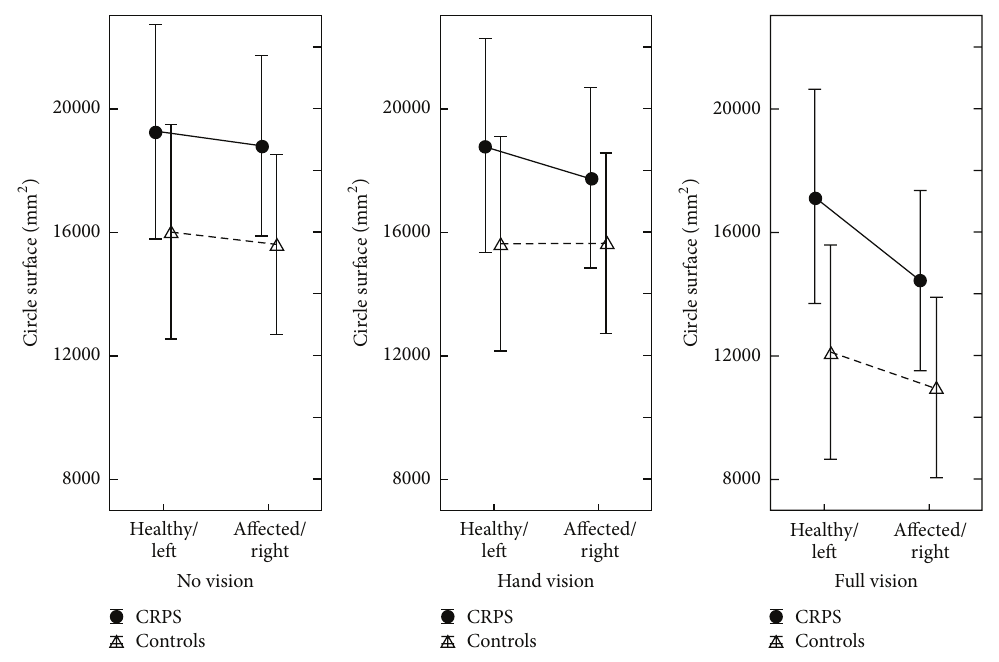
Figure 4: Circle drawing task for controls and CRPS patients in the three conditions (no vision, hand vision, and full vision) and for the two hands (left and right for controls, healthy and affected hands for patients). Overall CRPS tended to perform larger circles than controls. The more the visual feedback was available, the smaller the circles were for both controls and patients. A tendency to asymmetry between the two hands was paradoxically observed when vision was available in both groups. Errors bars depict the standard error of the mean.